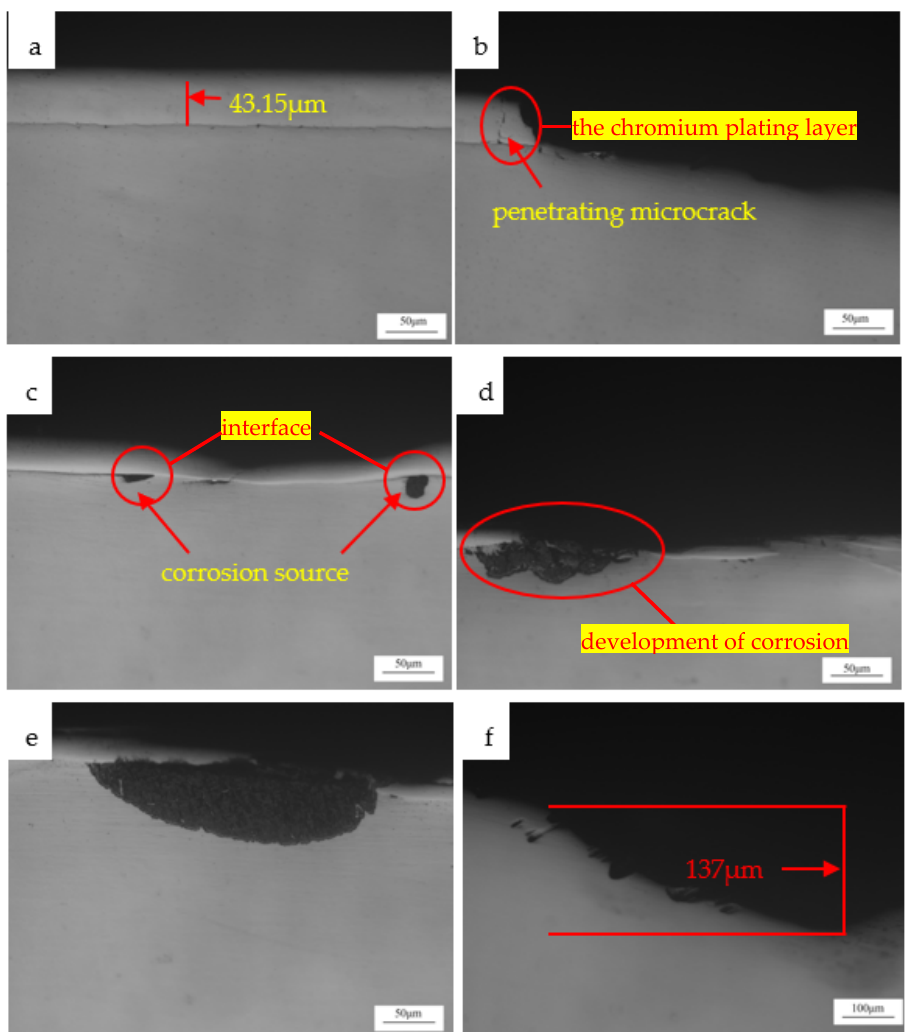
Figure 3. OM observation on the bonding state of the chromium plating layer and substrate: ( a ) intact part; ( b ) penetrating microcrack; ( c ) corrosion source; ( d ) development of corrosion; ( e ) aggravation of corrosion; ( f ) the cross ‐ section of corrosion pit .